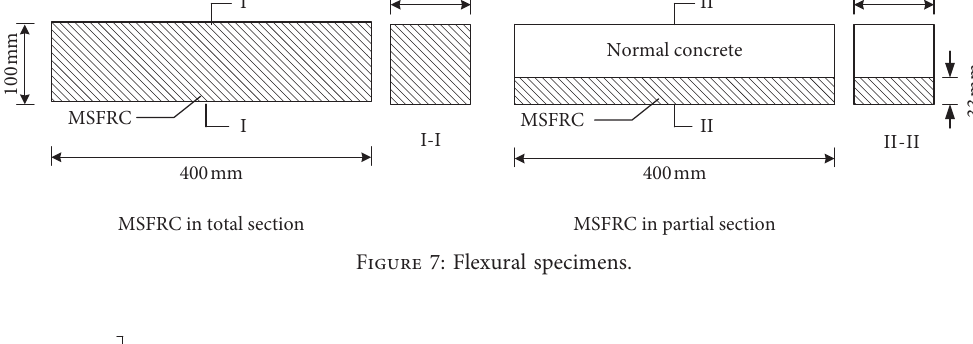
Figure 7: Flexural